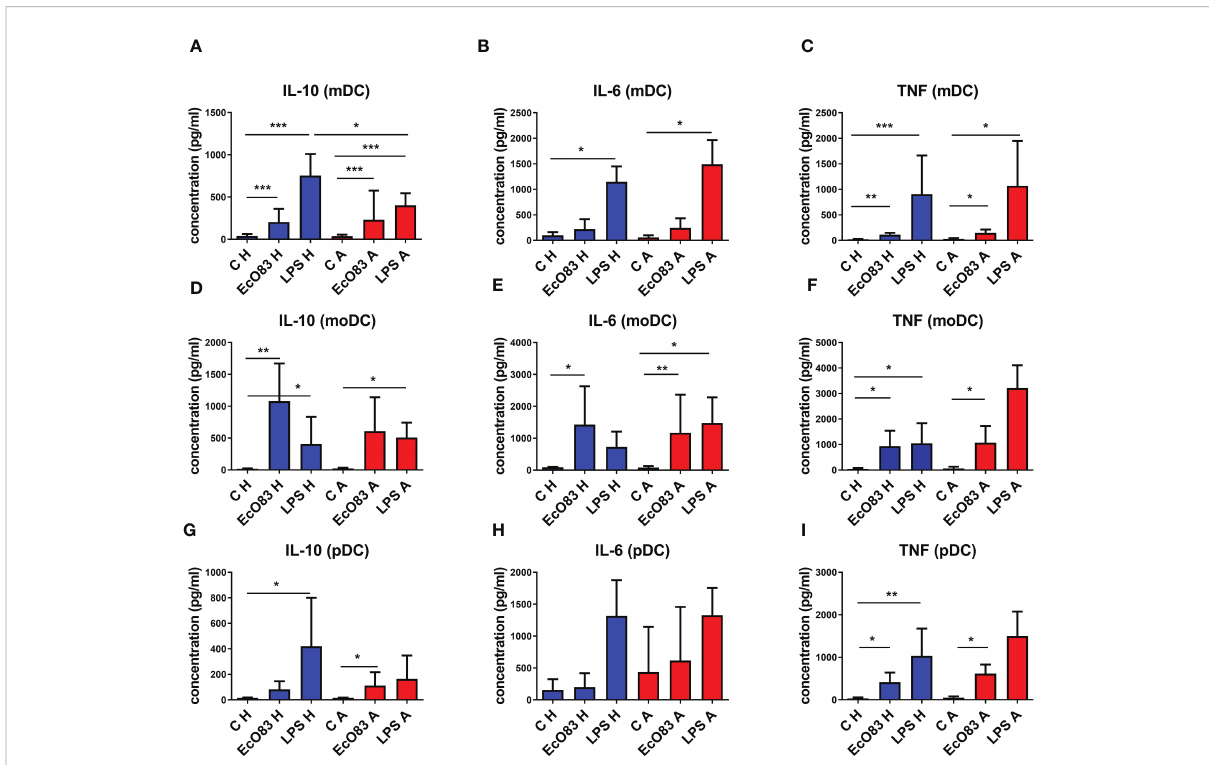
FIGURE 6 The impact of E. coli O83:K24:H31 (EcO83) stimulation on cytokine secretion by dendritic cells (DCs), as determined by ELISA. The capacity of EcO83 to promote IL-10 secretion by myeloid dendritic cells (mDCs) is shown in (A) . The impact of EcO83 on the production of pro- in fl ammatory cytokines IL-6 and TNF is shown in (B, C) , respectively. The capacity of EcO83 to promote IL-10 secretion by monocyte-derived dendritic cells (moDCs) is shown in (D) . Release of IL-6 and TNF by moDC is presented in ( E , F , respectively. The effect of EcO83 stimulation on the secretion of IL-10 by pDCs is documented in (G) . Concentration of pro-in fl ammatory cytokines IL-6 and TNF in cell culture supernatants of pDC stimulated with EcO83 and LPS is indicated in (H, I) . C H, non-stimulated DCs of newborns of healthy mothers; C A, non-stimulated DCs of newborns of allergic mothers; EcO83 H, DCs of newborns of healthy mothers stimulated with E. coli O83:K24:H31; EcO83 A, DCs of newborns of allergic mothers stimulated with E. coli O83:K24:H31; LPS H, DCs of newborns of healthy mothers stimulated with lipopolysaccharide; LPS A, DCs of newborns of allergic mothers stimulated with lipopolysaccharide; *p ≤ 0.0167 (adjusted p value); **p ≤ 0.0033 (adjusted p value); ***p ≤ 0.00033 (adjusted p value). IL, interleukin; TNF, tumor necrosis